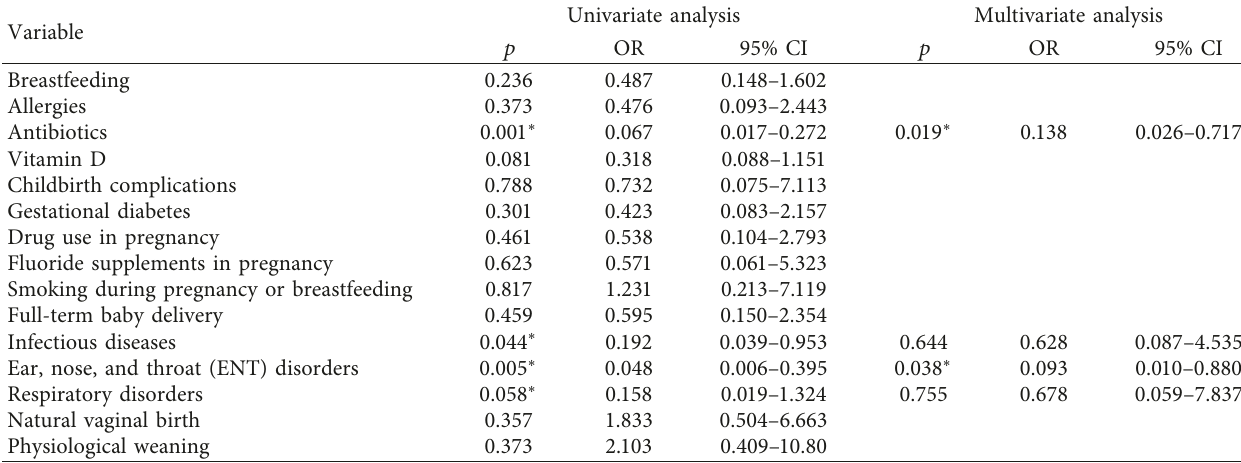
Table 3: Univariate and multivariate analysis for etiological factors of